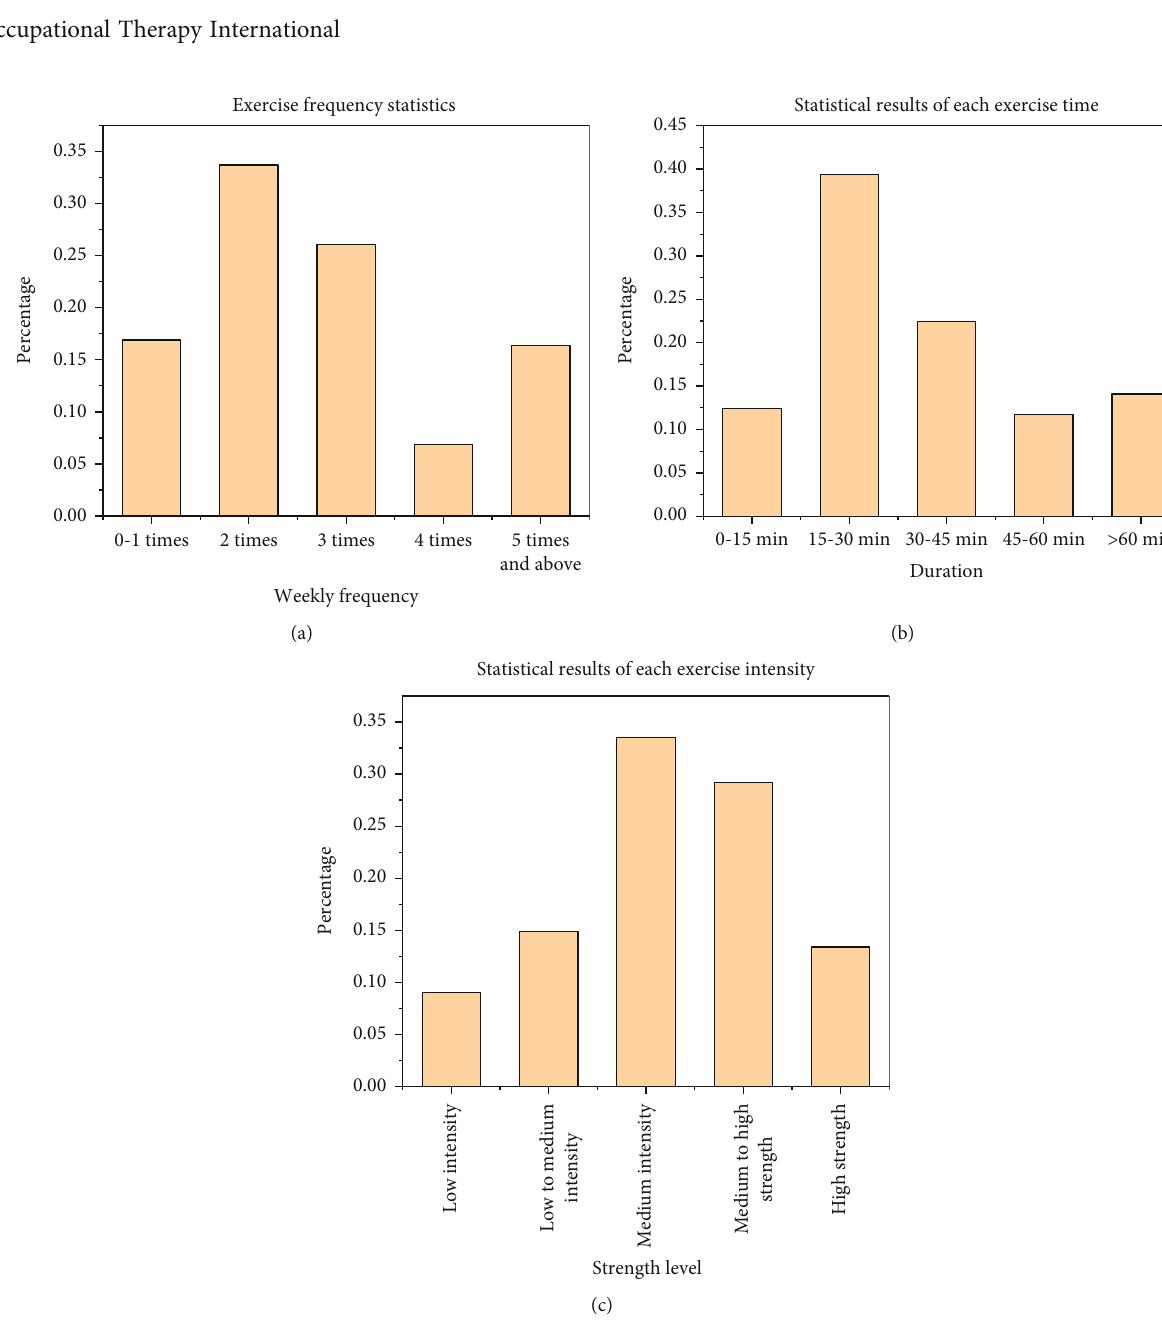
Figure 4: Results of frequency, duration, and intensity of home exercise ((a) weekly frequency; (b) duration; (c) strength